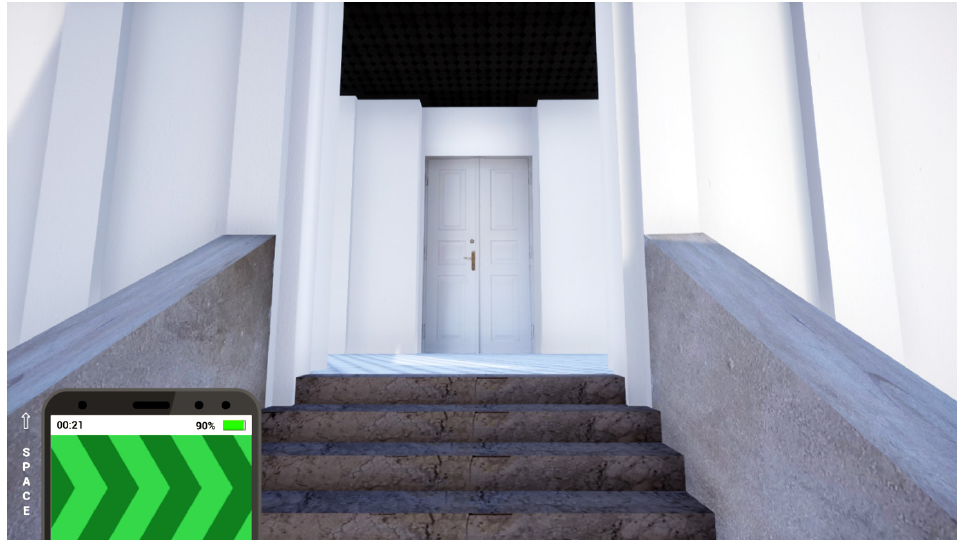
Fig. 7. Screenshot of the developed application from the experiment’s starting point. A view of the 3D space from a first­person perspective is shown, as well as the interface elements: a virtual phone displaying navigational directions and text with supporting instructions (the text shown on this screen: “Move around using the WASD or arrow keys. Look around by moving the mouse.”)